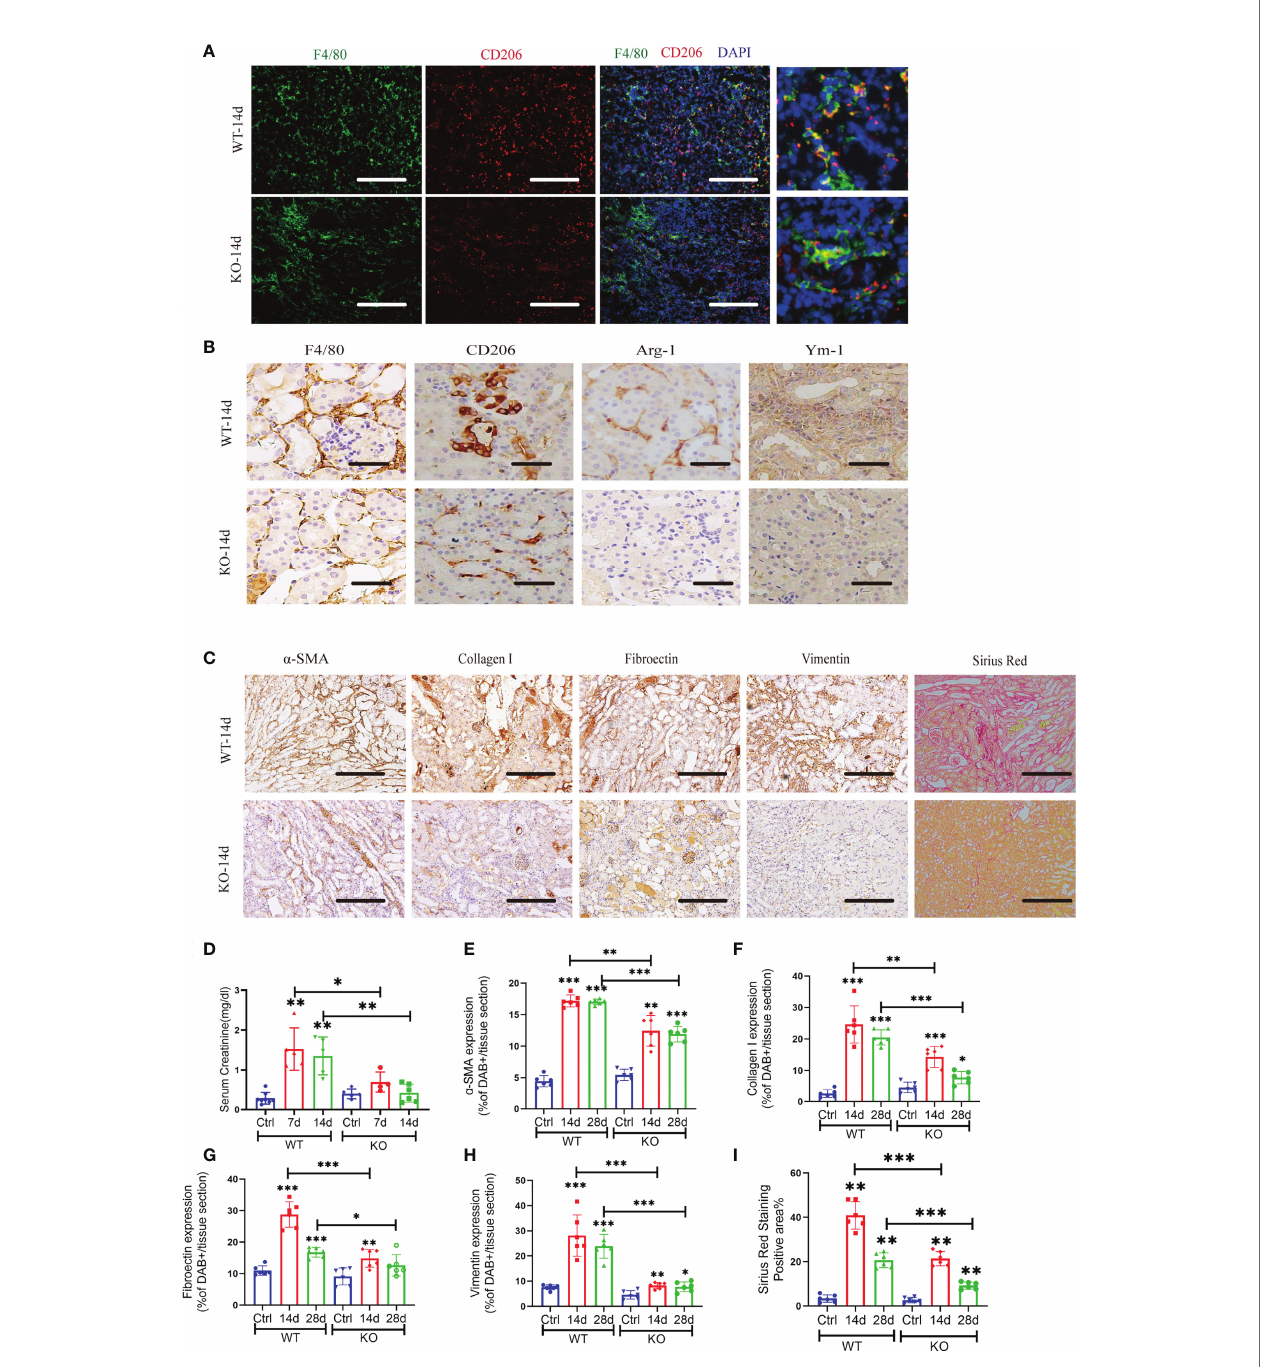
FIGURE 3 | Blockade of miR-382 inhibits M2 polarization in the kidney and attenuates AA-induced CKD. (A) Images of co-staining for F4/80, CD206, and DAPI in renal sections from WT-14 days and KO-14 days. F4/80 was marked as green. CD206 was marked as red. Nucleic was blue. Scale bars, 200 m m. (B) Representative immunostaining for F4/80, CD206, Arg-1, and Ym-1 in WT and KO mice of 14 days of AAN. Scale bars, 20 m m. (C) Representative Sirius Red staining and immuno-histochemistry staining with antibodies against a -SMA, collagen I, fi bronectin, and vimentin in renal sections from WT and KO of 14d AAN. Scale bars, 200 m m. (D) Serum creatinine of wild-type (WT) and miR-382 knockout (KO) mice with AA treatment for 7 and 14 days; saline was administered as control treatment. (E – H) Quanti fi cation of positive area for a -SMA, collagen I, fi bronectin, and vimentin. Five microscopical fi elds were randomly selected per section, and the average positive area was calculated; n = 6 mice per group. (I) Quanti fi cation of mean positive area for Sirius Red staining. Five microscopical fi elds were randomly selected per section, and the average positive area was calculated; n = 6 mice per group. * P < 0.05; ** P < 0.01; *** P < 0.001;